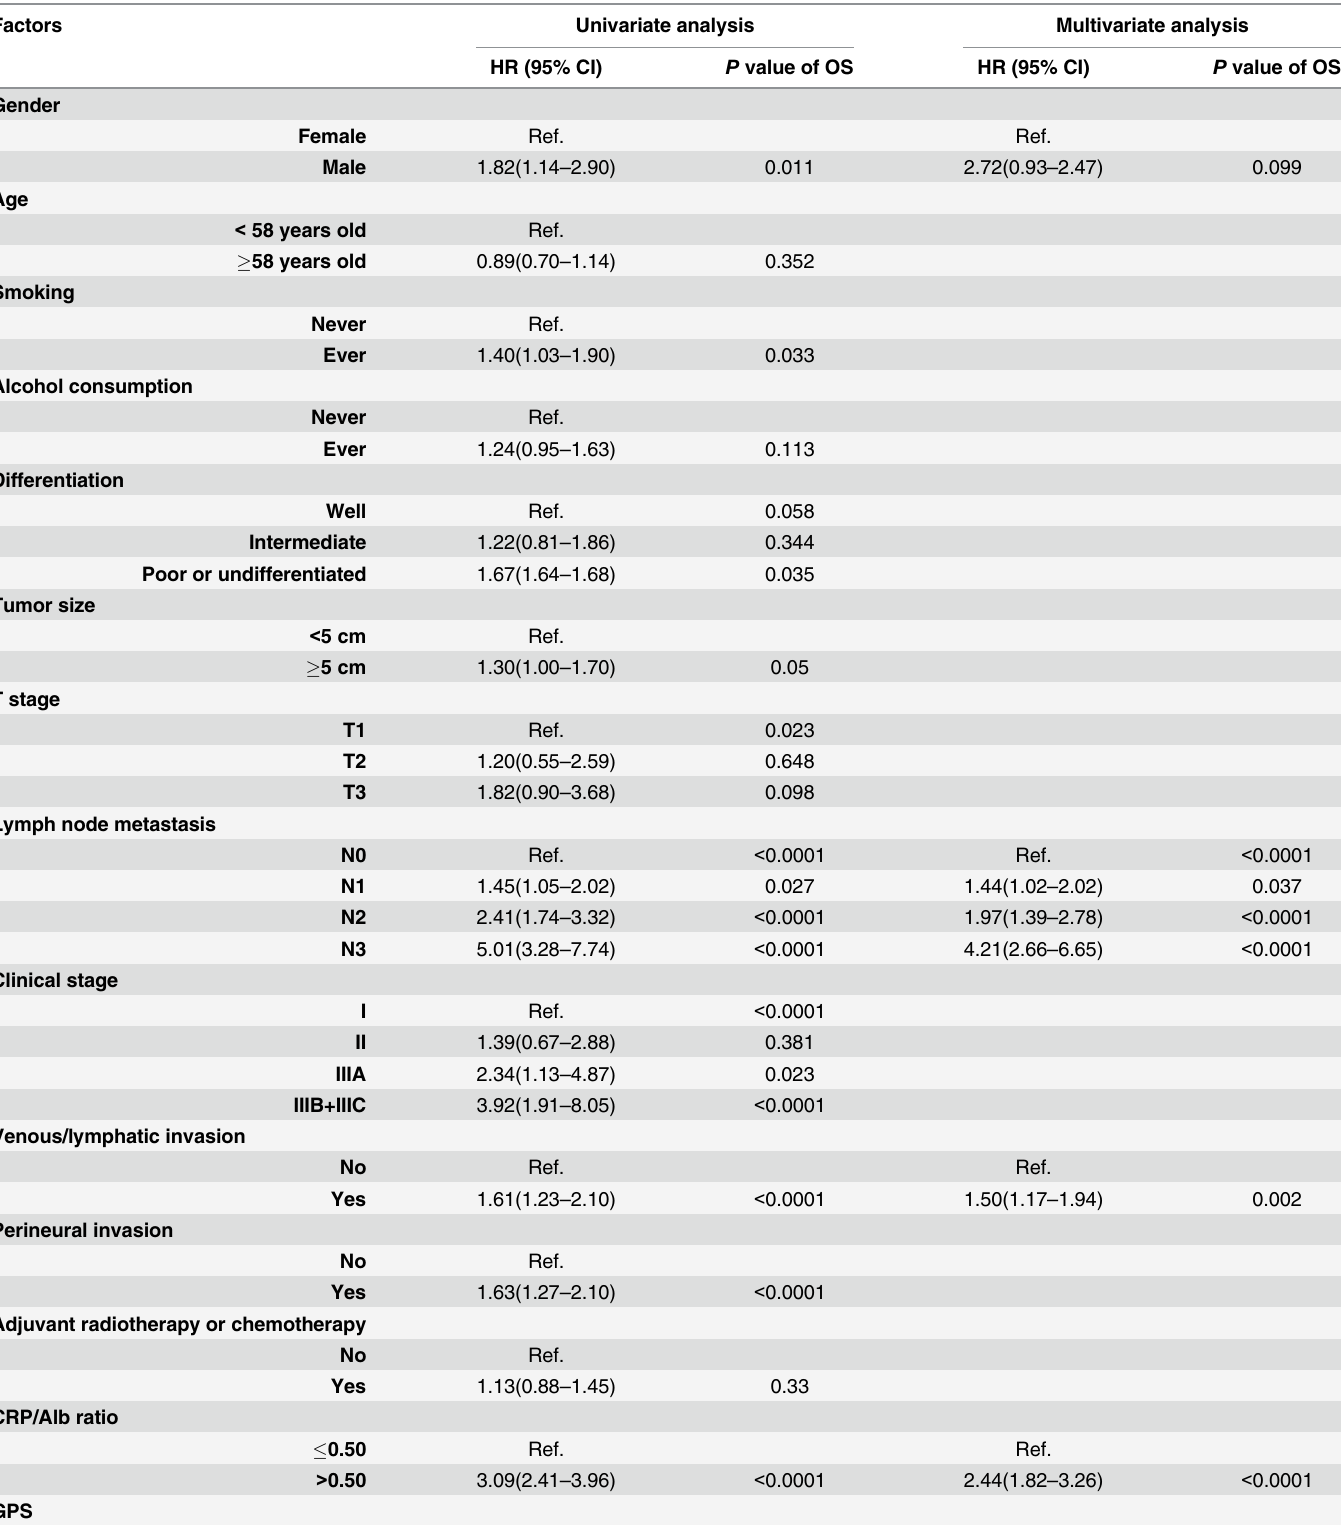
Table 3. Prognostic factors for overall survival identified by univariate and multivariate